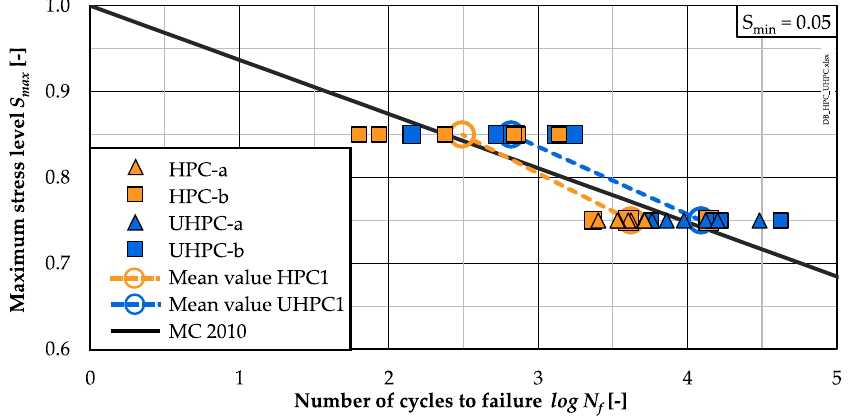
Figure 4. Number of cycles to failure for the HPC and UHPC.